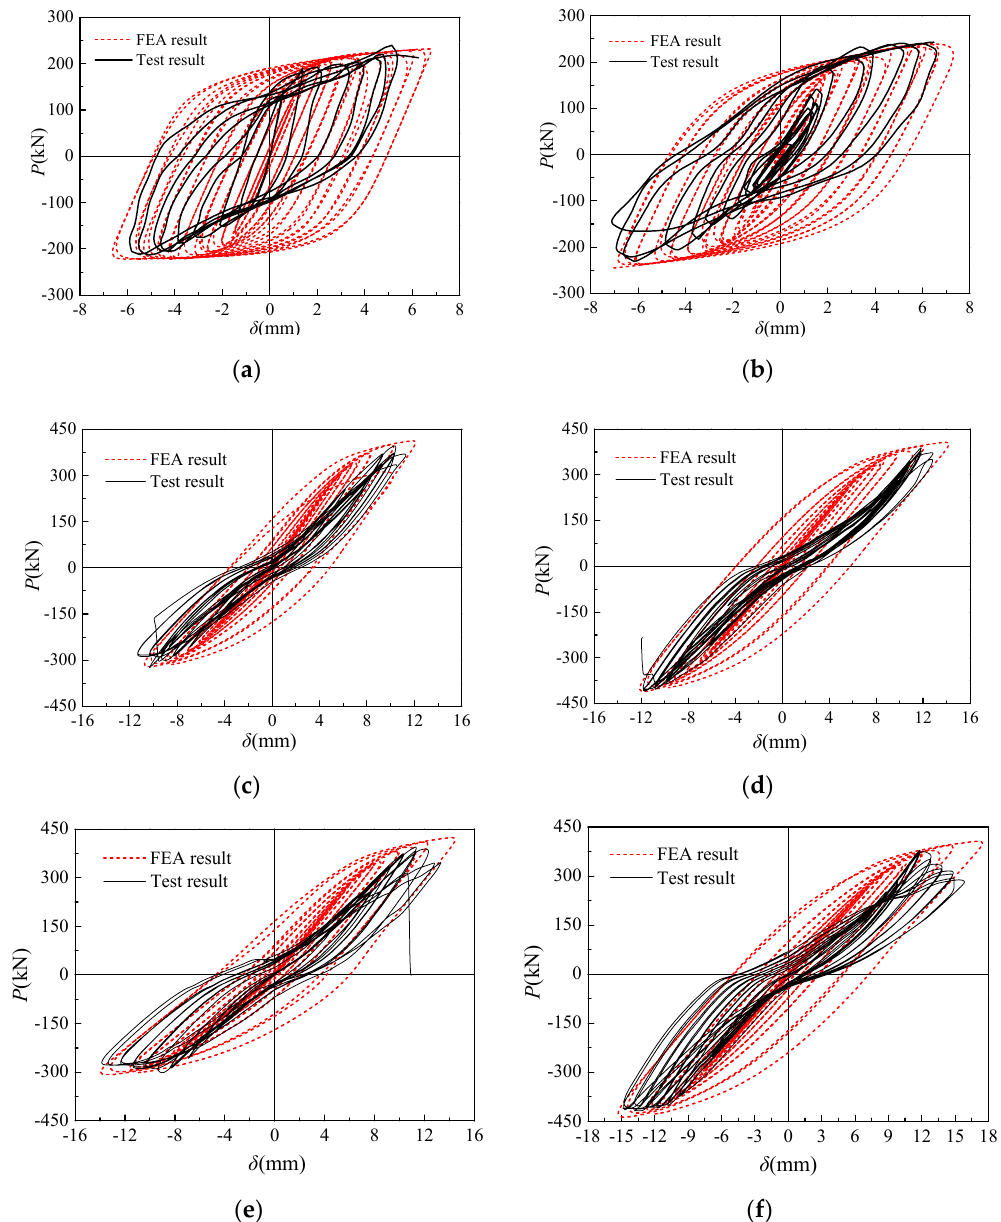
Figure 13. Comparison of hysteretic curves between test and finite element analysis. ( a ) K-CC; ( b ) K-RC; ( c ) K-CCC1; ( d ) K-RCC1; ( e ) K-CCC2; ( f ) K-RCC2. Table 5. The bearing capacity comparison of joints.